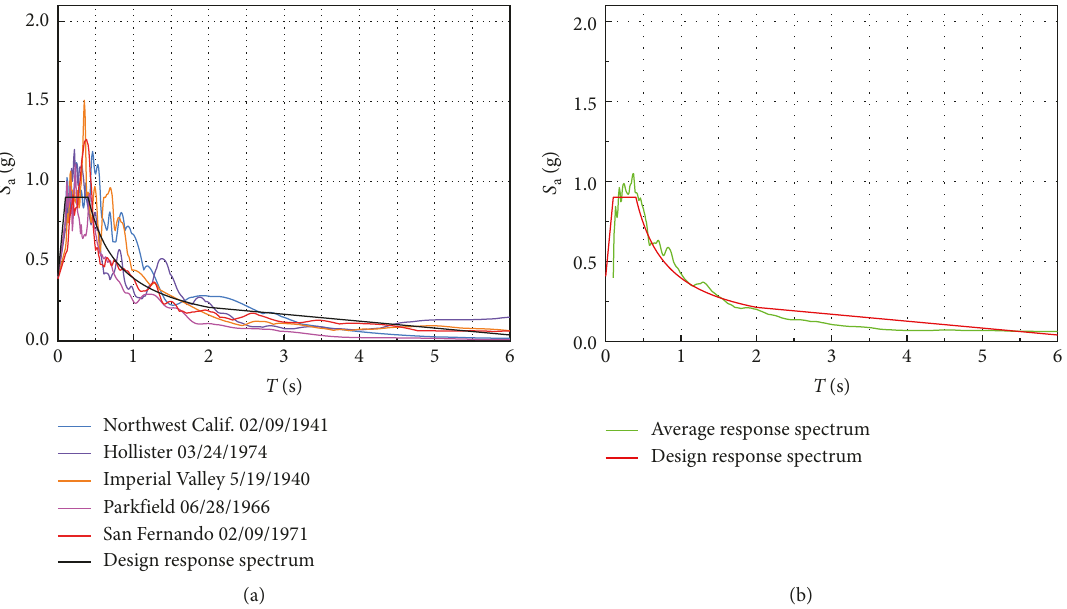
Figure 16: Response spectra of selected seismic waves. (a) Comparison of selected seismic wave and design response spectra. (b) Comparison of average and design response spectra.